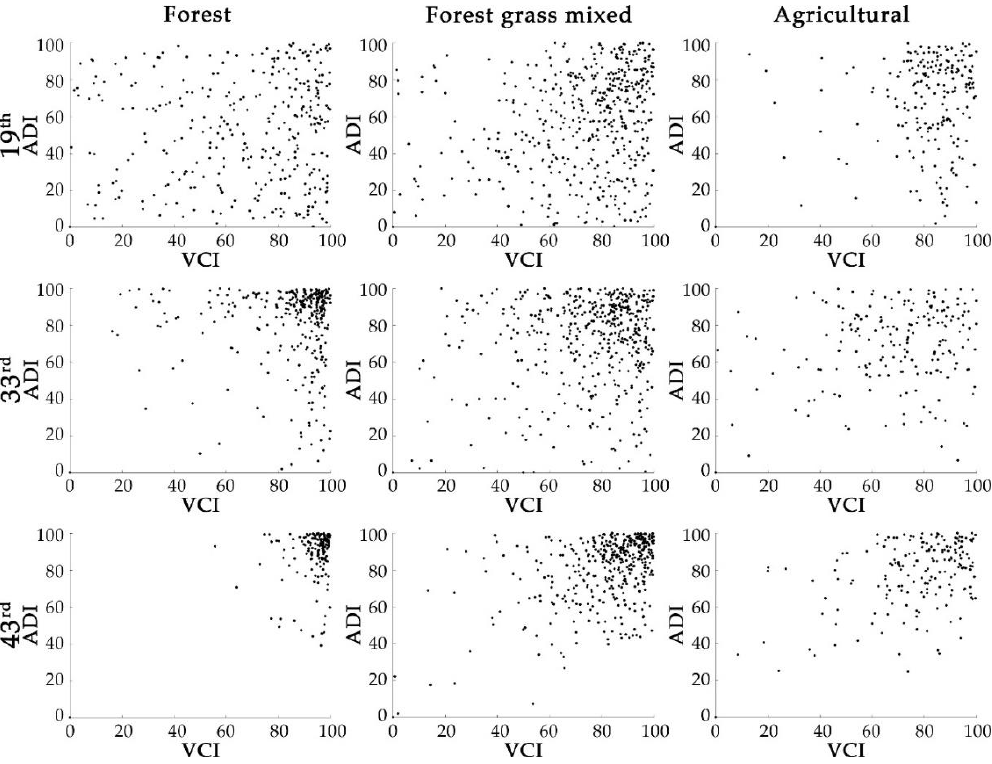
Figure 3. Scatter diagram of VCI and ADI of 19th, 33rd and 43rd periods of different land use types in 2016.